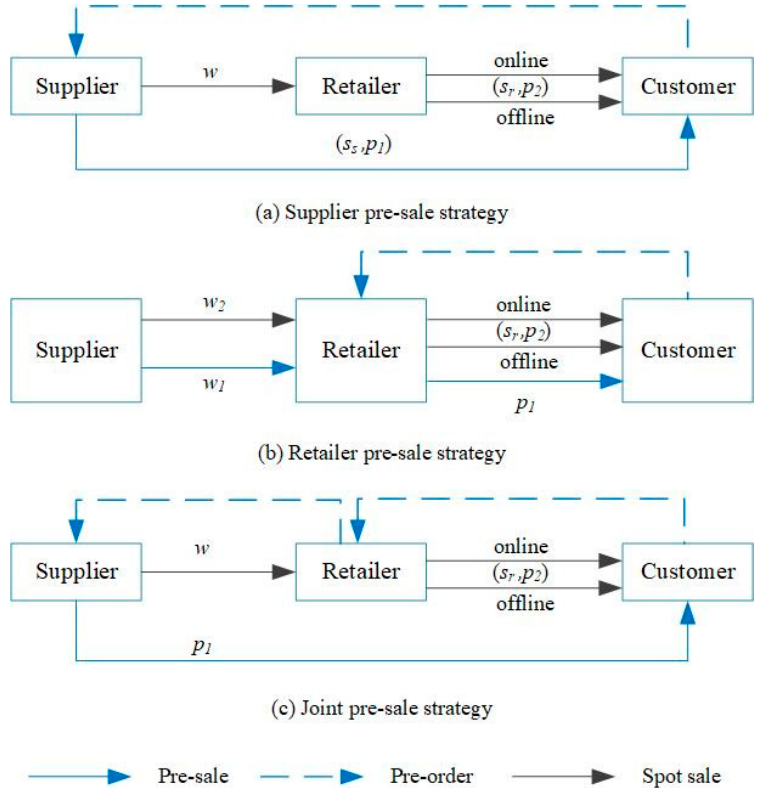
Figure 1. Structure of the fresh agri-product supply chain under three strategies: ( a ) Supplier pre-sale strategy, ( b ) Retailer pre-sale strategy ( c ) Joint pre-sale strategy.